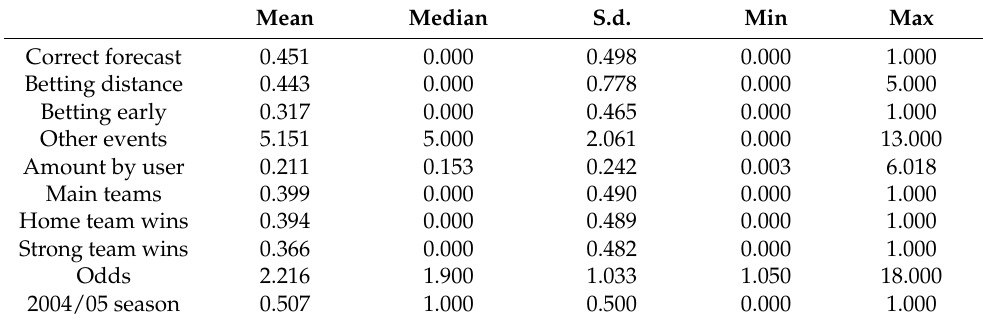
Table 1. Descriptive